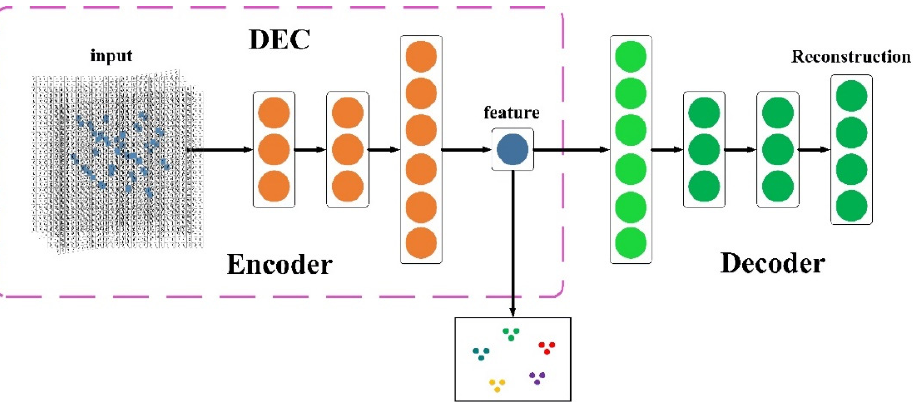
Figure 5. The framework of DEC.